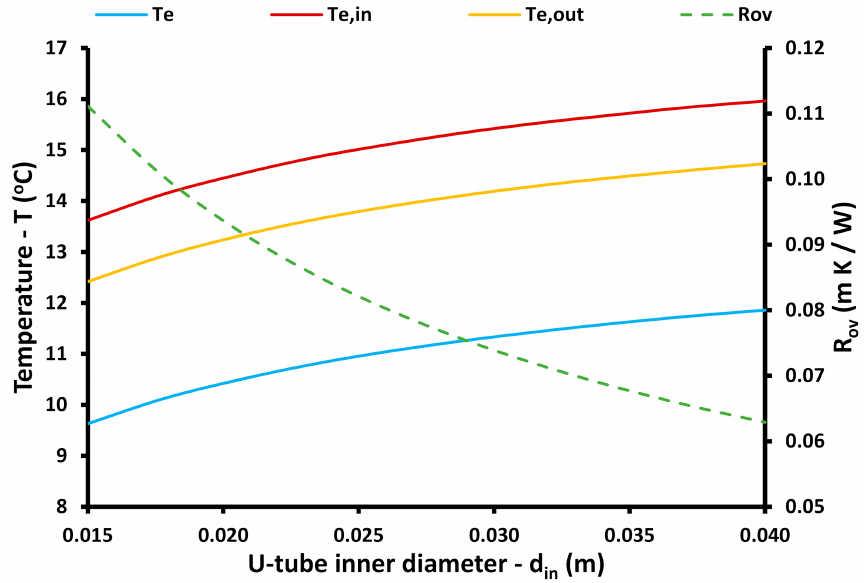
Figure 19. The impact of the U-tube inner diameter on the evaporator temperature levels and on the overall